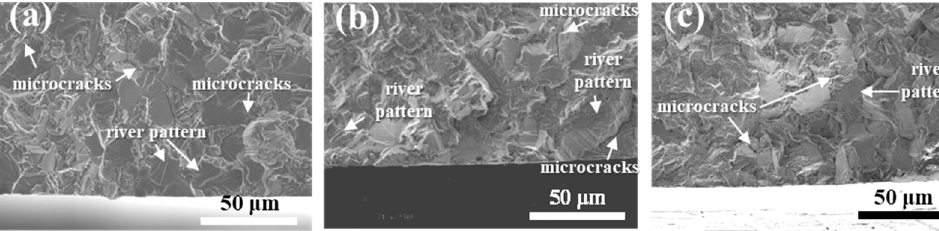
Figure 4. SEM fractographs of samples at maximum cyclic stresses of 600 MPa: ( a ) FS (N = 1.03569 × 10 5 cycles), ( b ) RS (7.28959 × 10 5 cycles), and ( c ) HS (1.128265 × 10 6 cycles).